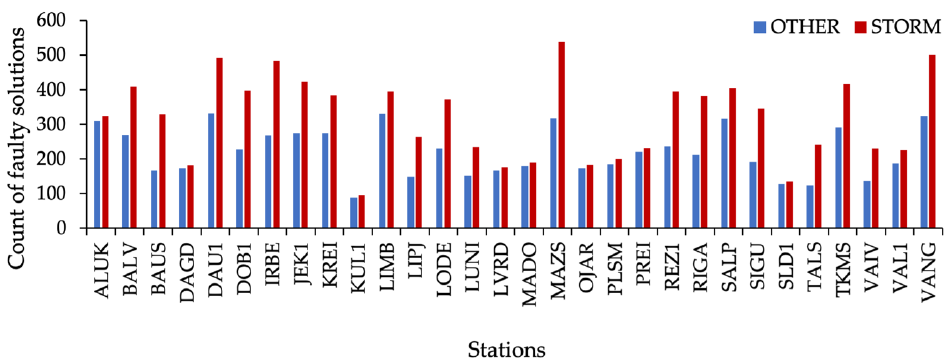
Figure 6. Count of faulty solutions of each station in subsets 𝑝 𝑖 ∊ 𝐵 for 17 March (STORM) and in subsets 𝑝 𝑖 ∊ 𝐵 on other days in March 2015 (OTHER).